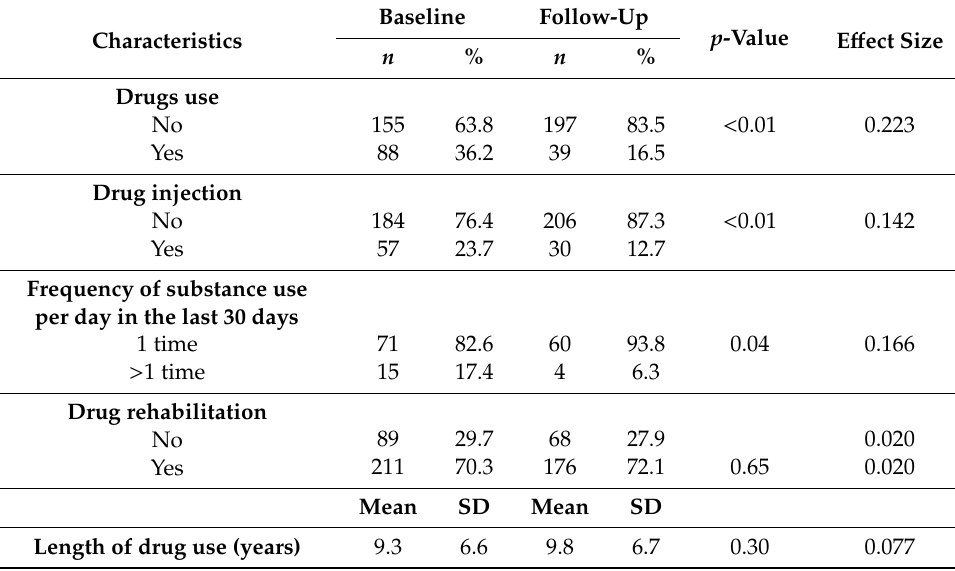
Table 2. Patient drug use characteristics.